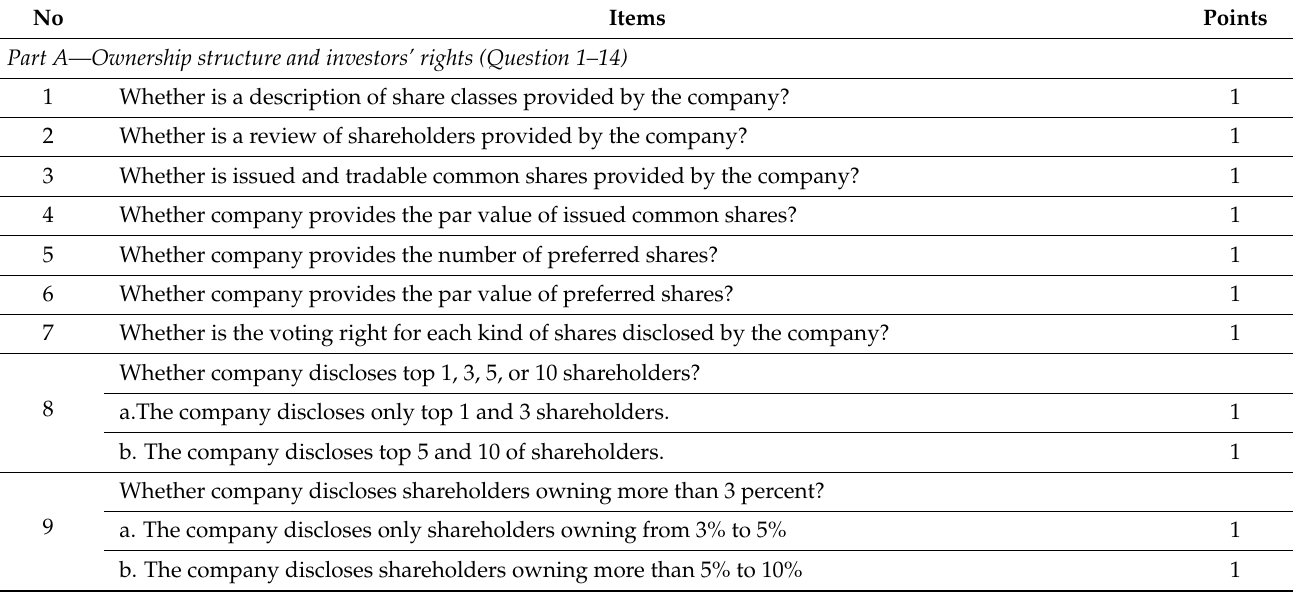
Table A1. The transparency and disclosure